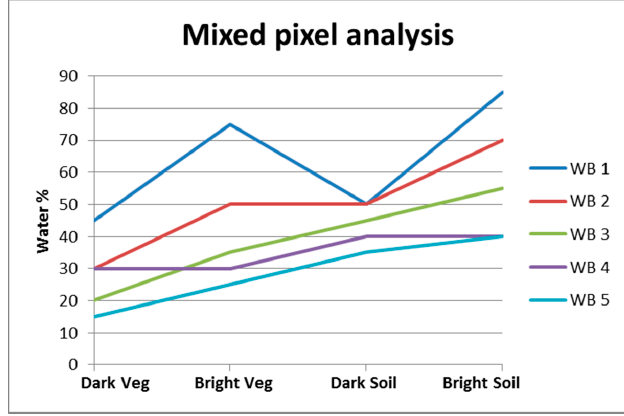
Figure 9. The minimum fraction of the pixel to be covered by water in order to be detected as